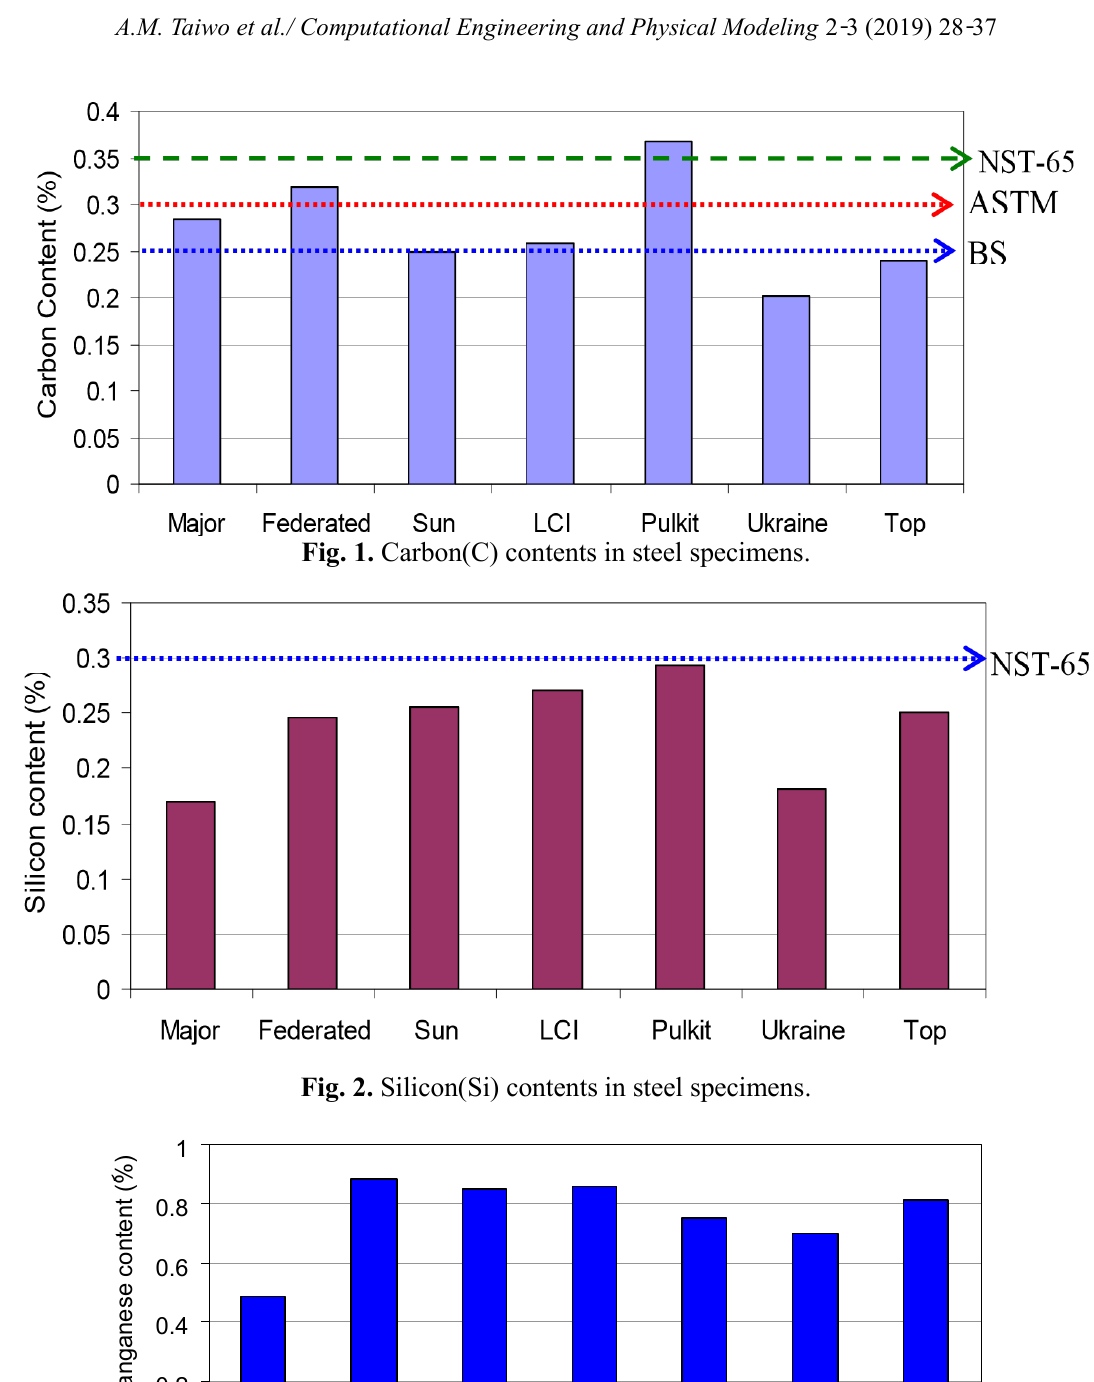
Fig. 3. Manganese(Mn) contents in steel